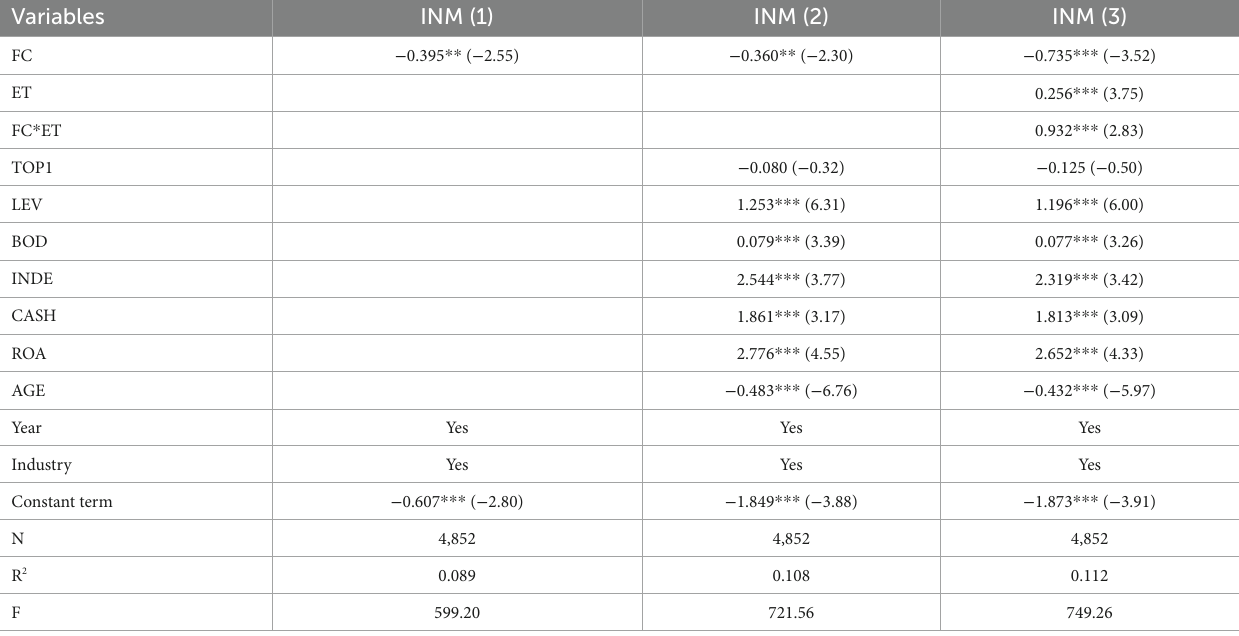
TABLE 4 Multiple regression analysis results.